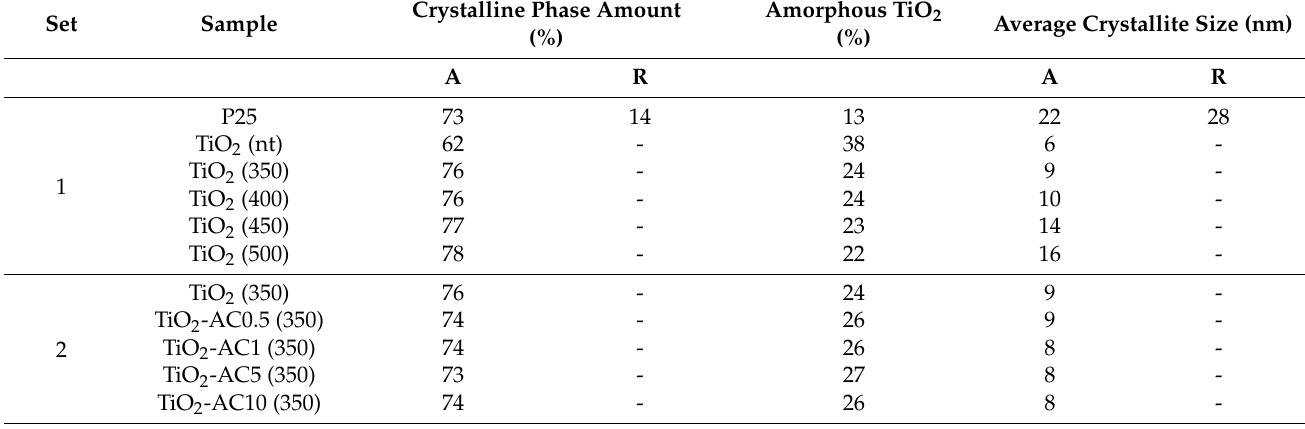
Table 1. Crystalline and amorphous TiO 2 contents, as well as mean crystallite size, for P25, TiO 2 (nt) and TiO 2 (T) samples (Set 1) and for TiO 2 -ACx (350) (x = 0, 0.5, 1, 5, and 10 wt.%) samples (Set